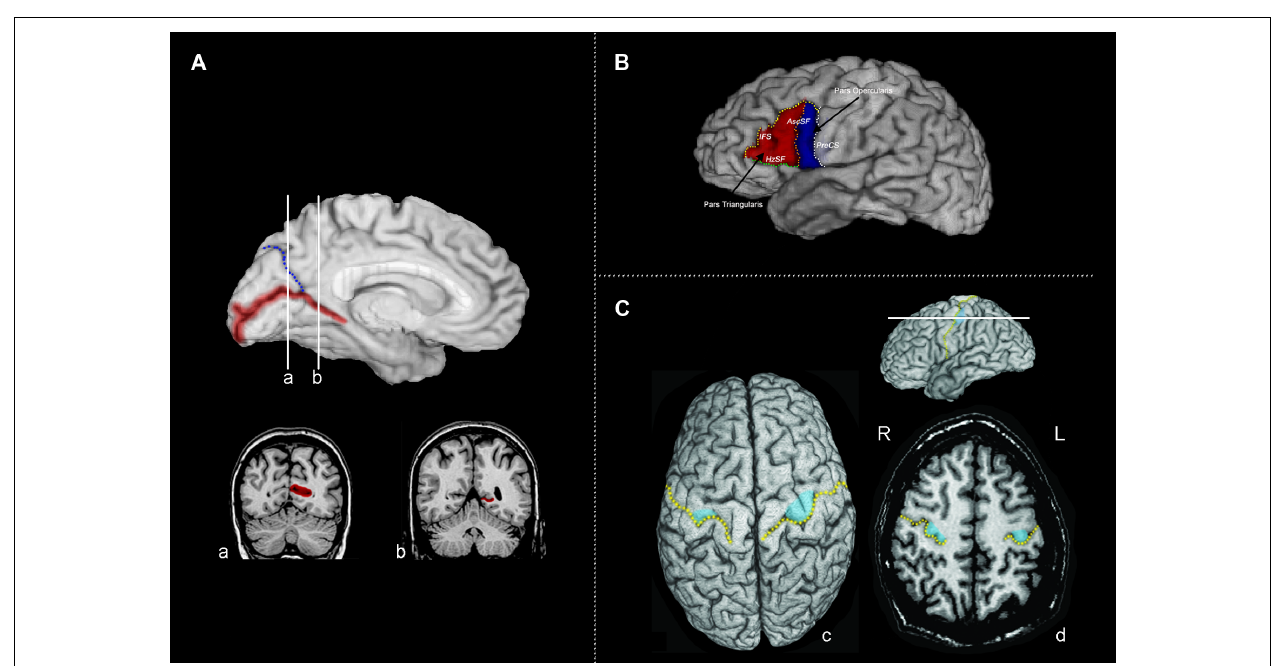
sulcus (yellow); AscSF, ascending branch of the Sylvian fissure (coral); HzSF, horizontal branch of the Sylvian fissure (green); PreCS, precentral sulcus (white). (C) Tracing the motor handknob. (c) The position of the motor handknob (blue) is projected to the surface of the precentral gyrus.The central sulcus is indicated by the broken gold line. (d) An axial slice demonstrating the two classic forms of the handknob: the epsilon form in the right hemisphere and the omega form in the left hemisphere. All volumetric tracing of the handknob was done on contiguous 1-mm axial slices. R, right; L,